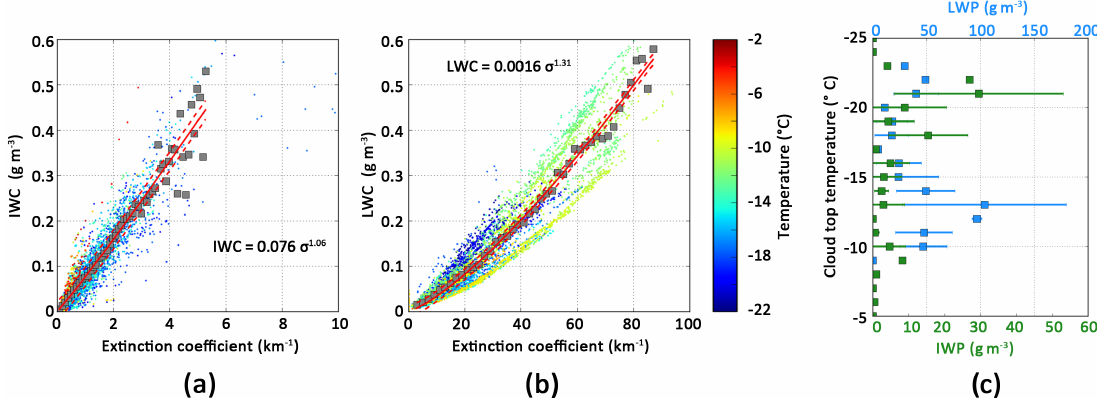
Figure 8. (a) IWC and (b) LWC as a function of extinction coefficient. Color scale indicates the temperature; grey squares represent the values averaged over extinction coefficient intervals of 0.1 and 2km − 1 for IWC and LWC, respectively. The red lines represent the curve fittings and the dashed lines the uncertainties on the fitted relationships (mean absolute errors). (c) Ice (green) and liquid (blue) water paths according to the cloud top